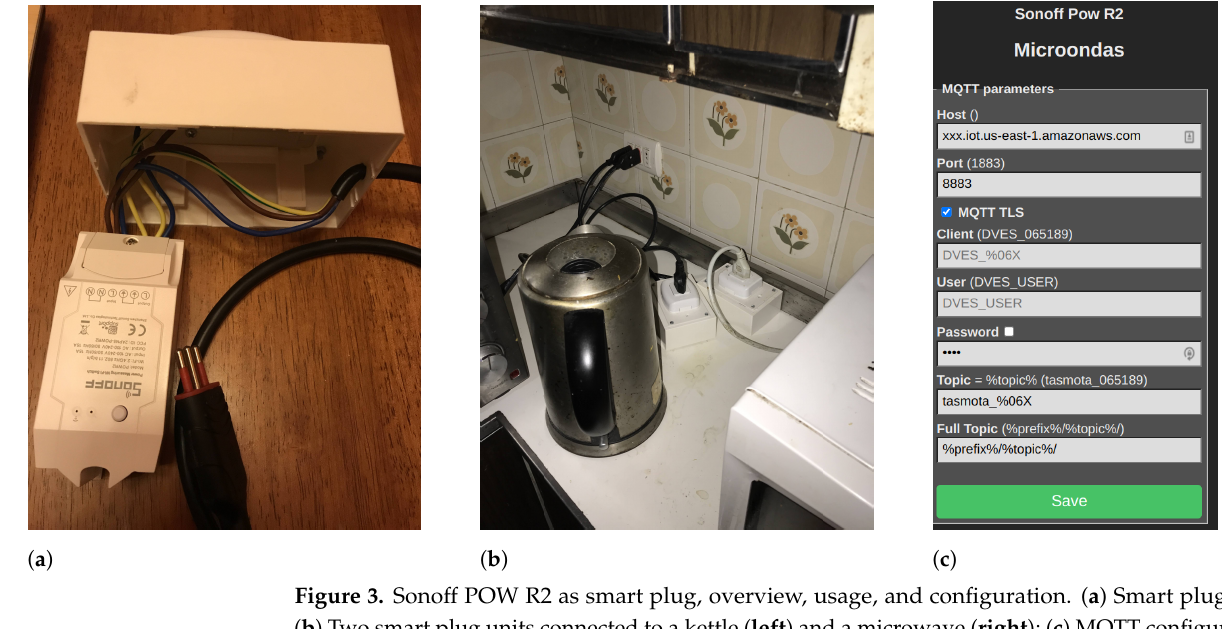
Figure 3. Sonoff POW R2 as smart plug, overview, usage, and configuration. ( a ) Smart plug unit; ( b ) Two smart plug units connected to a kettle ( left ) and a microwave ( right ); ( c ) MQTT configuration on Tasmota web interface.